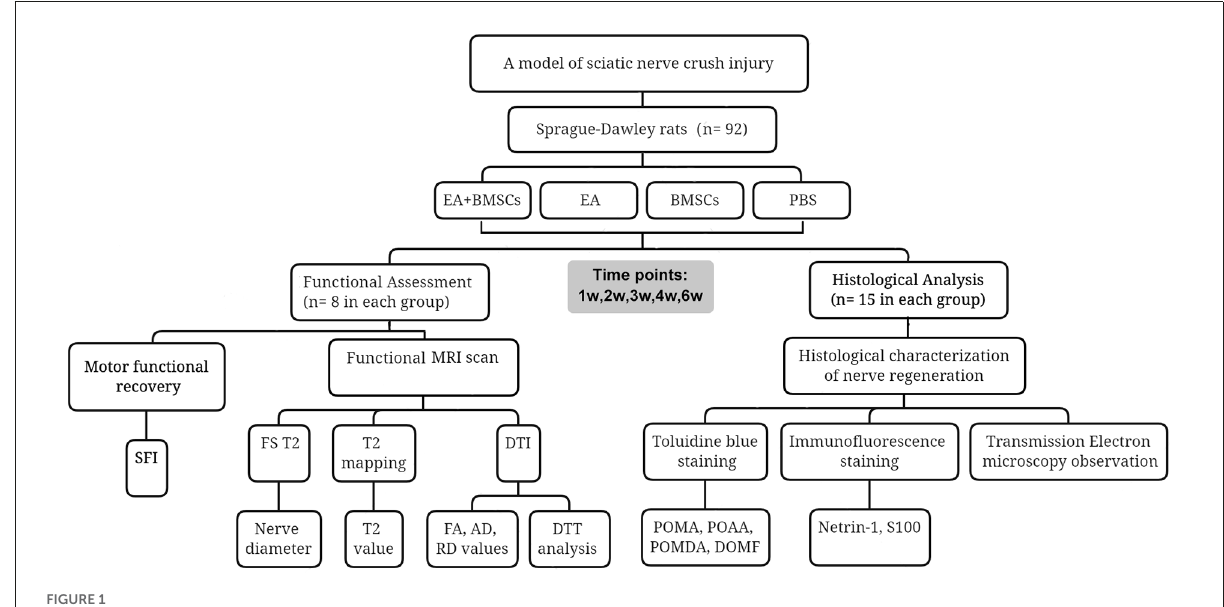
FIGURE1 Study timeline and